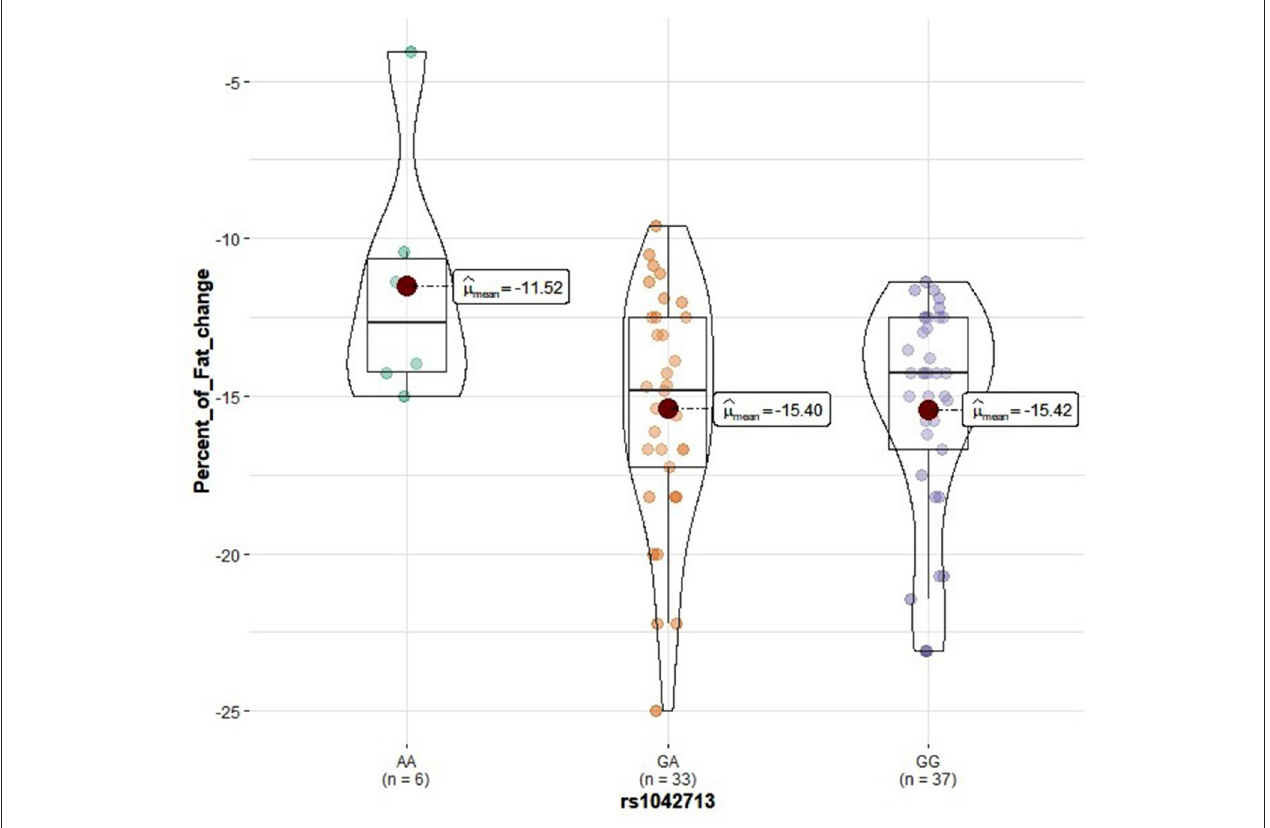
FIGURE 4 | Violin plots displaying the mean values of fat percentage change before and after the intervention in the vitamin D group according to rs1042713 genotype profile.